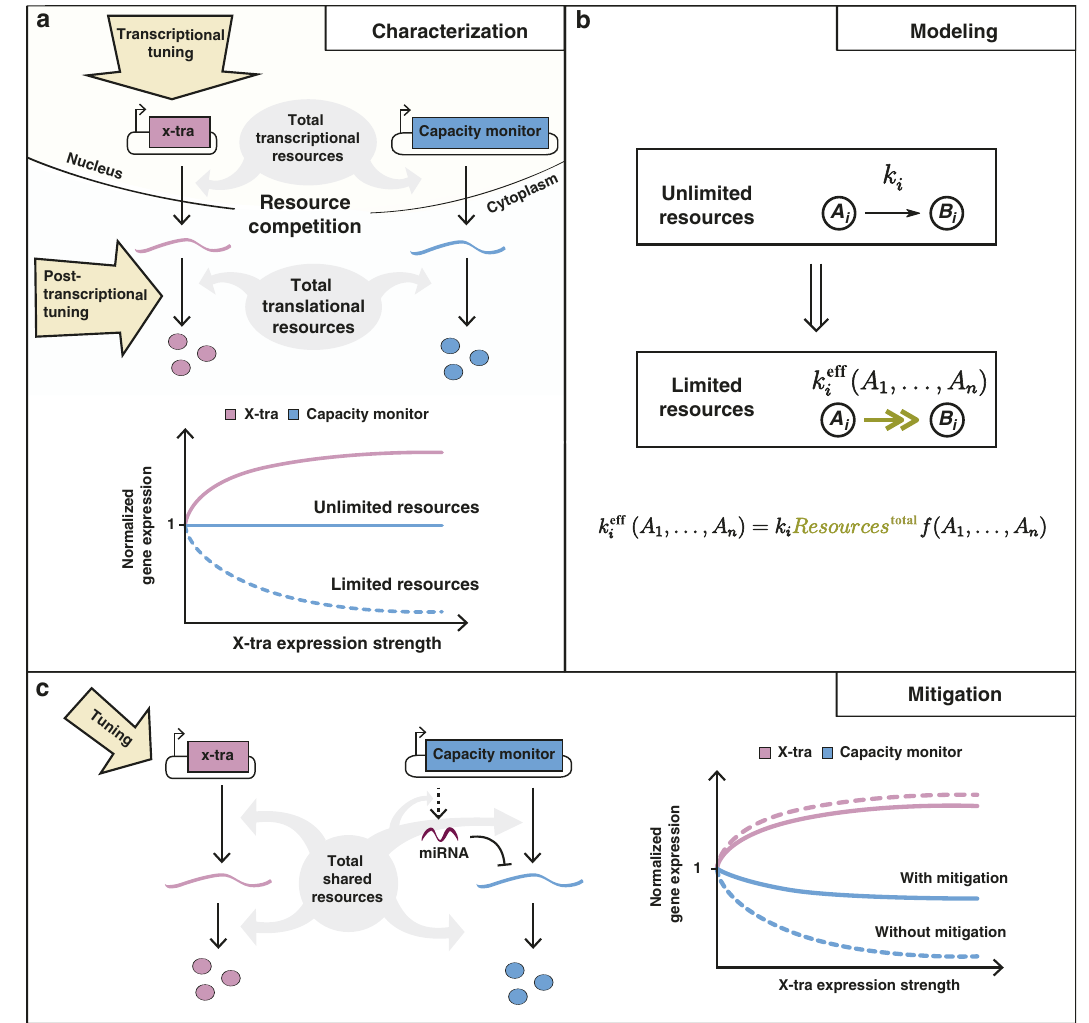
Fig. 1 Resource sharing and the origin of gene expression burden. a Characterization of gene expression burden. Expression of independent exogenous genes impacts on host cellular resources. Thus, perturbations in one gene ’ s expression (hereby named X-tra) affect the expression of a second gene (hereby named capacity monitor). b Modeling of gene expression in a resource-limited environment. Modeling of gene expression is generally